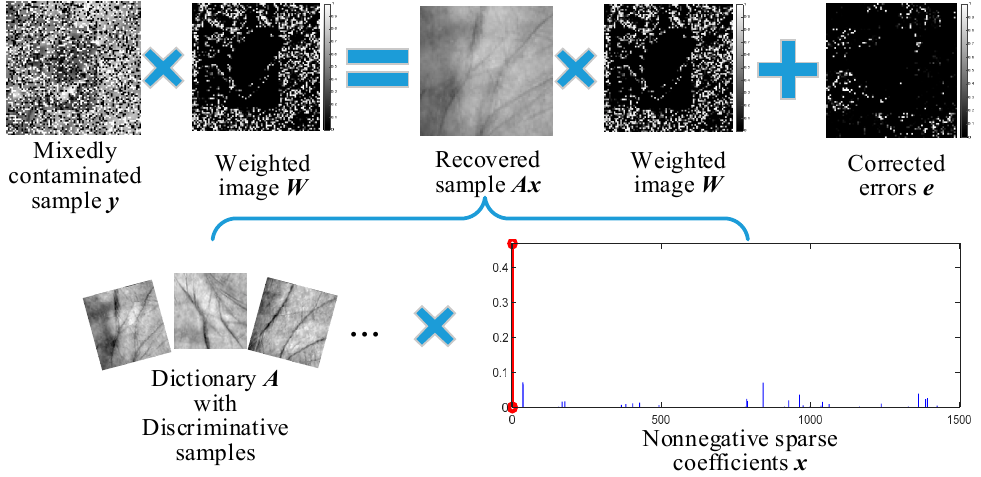
Figure 1. Regression-based CDNSC. The mixedly contaminated query sample can be expressed as a linear combination of the weighted discriminative dictionary samples plus the corrected errors.